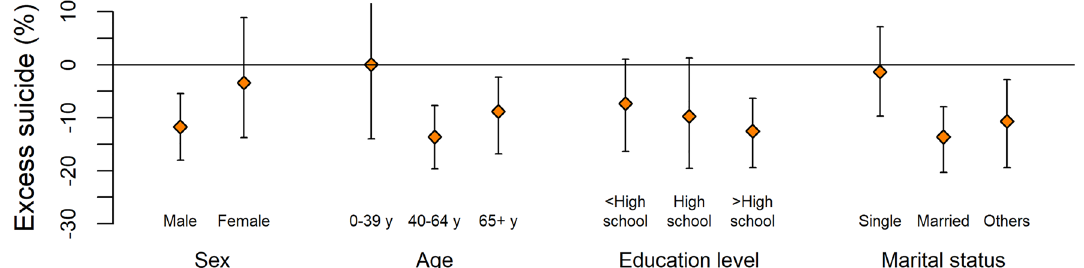
Figure 2. Percent excess and 95% CI in suicide during the period February 18–December 31, 2020 in Korea by sex, age, education level, and marital status. In terms of marital status, others include divorced and widowed people. CI confidence